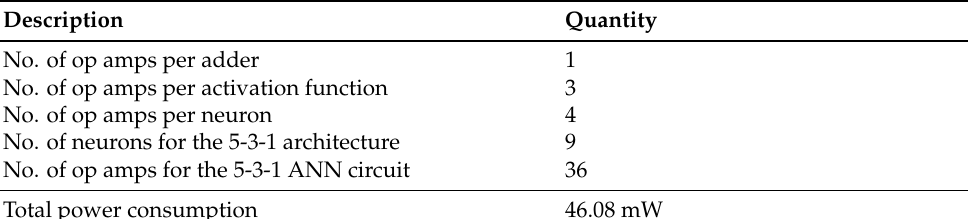
Table 6. Number of op-amps and total power